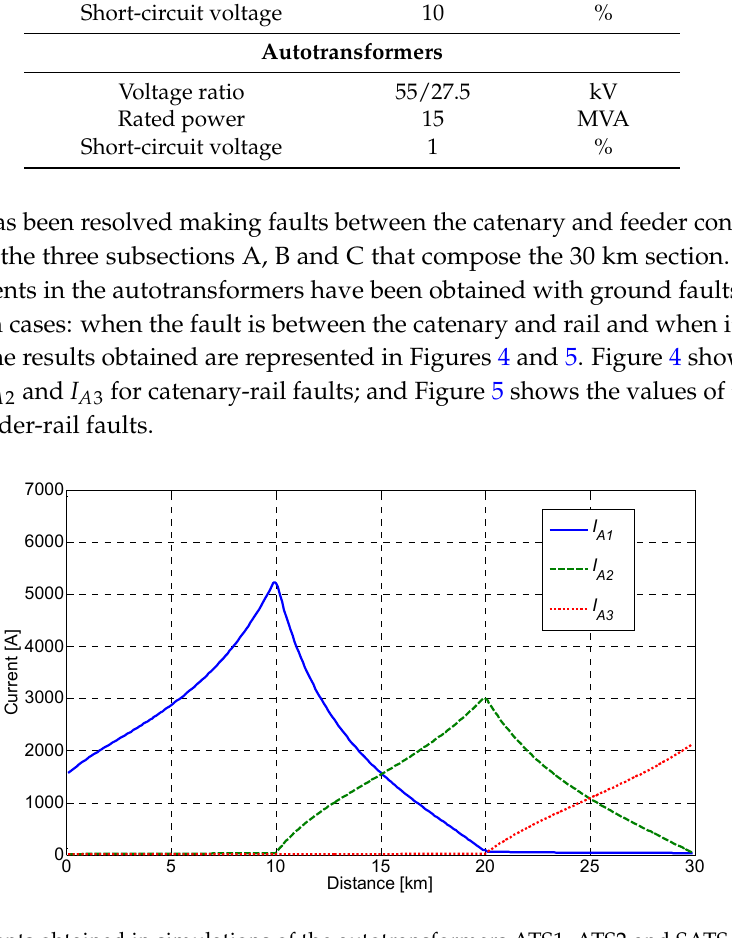
Table 2. Transformers and autotransformers ratings used in the simulation.